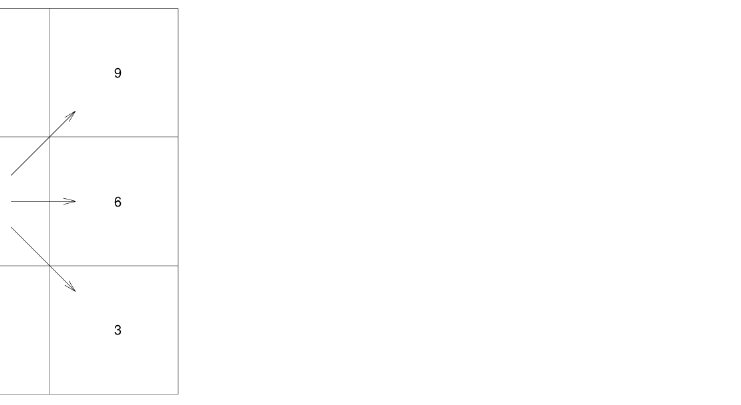
Figure 1. The numbers in each grid indicate the different states, and the vectors represent the actions for the 2D case.